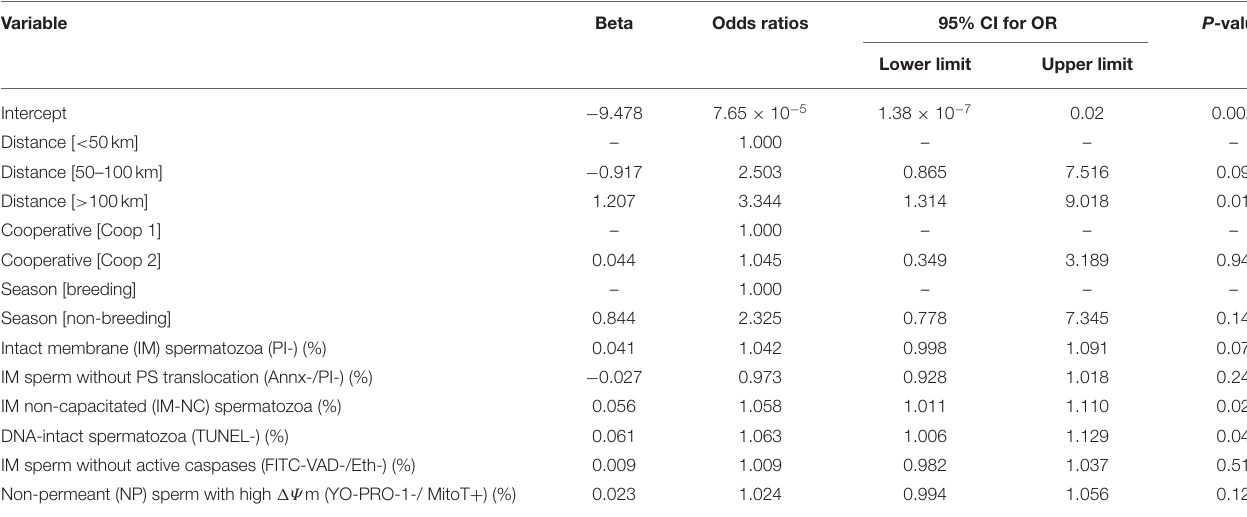
TABLE 6 | Multiple logistic regression results of fertility > 52% ( n =